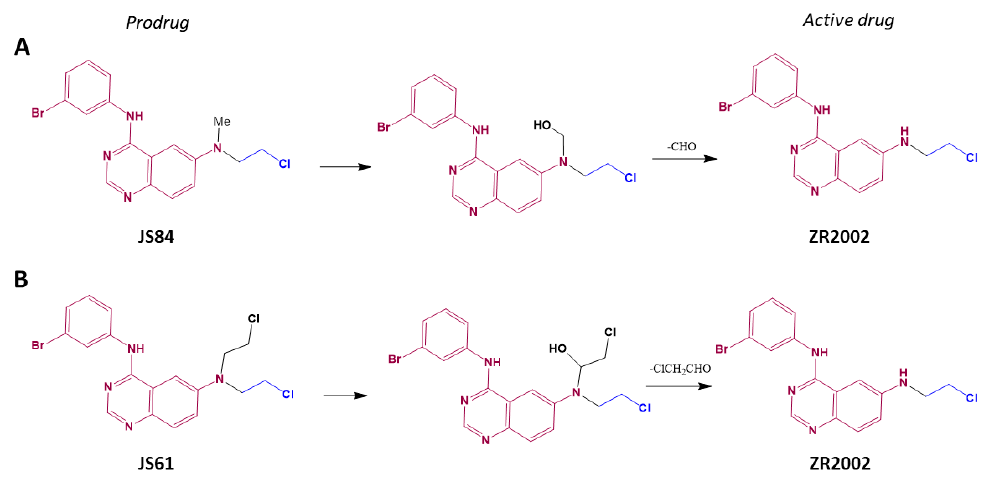
Figure 1. Proposed in vivo metabolism pathways toward conversion of the combi-molecules JS84 ( A ) and JS61 ( B ) to ZR2002.